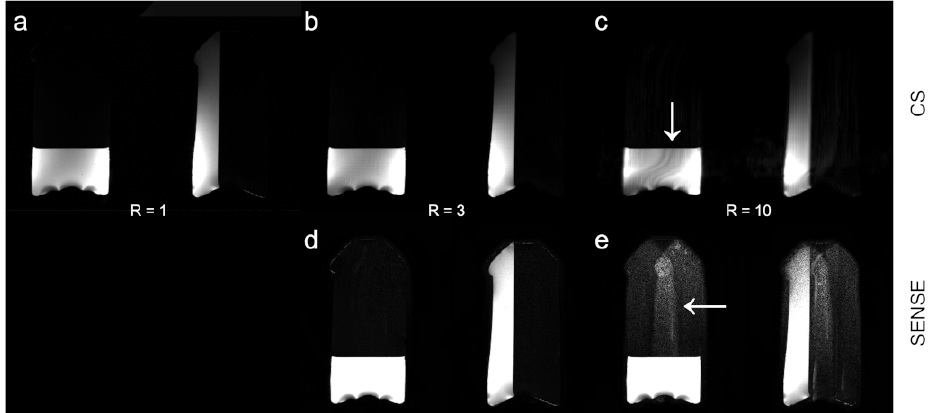
Figure 4. Illustration of artifacts apparent at high R levels. HiSS MRI water peak height (WPH) images are shown for increasing acceleration factors R for CS and SENSE acceleration methods. WPH images for ( a ) R = 1, ( b ) CS R = 3, ( c ) CS R = 10, ( d ) SENSE R = 3, and ( e ) SENSE R = 10 are depicted. The WPH images are scaled to illustrate slight spatial inhomogeneity in the image-left volume of the phantom in CS images and the amplification of the geometric artifact in SENSE-accelerated images at R = 10. The artifacts are indicated by arrows.